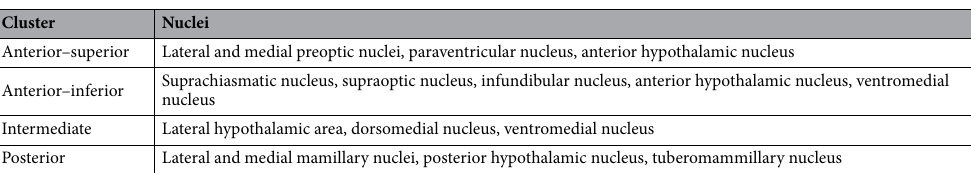
Table 2. Assignment of hypothalamic nuclei to clusters obtained by k-means clustering based on diffusion orientation distribution functions.